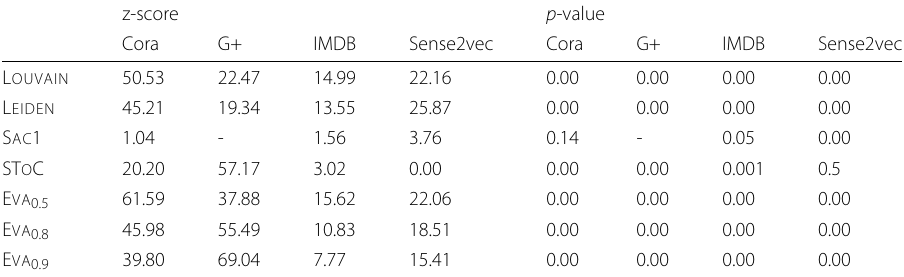
Table 2 Single-nominal: statistical significance of the partitions z-score p -value Cora G+ IMDB Sense2vec Cora G+ IMDB